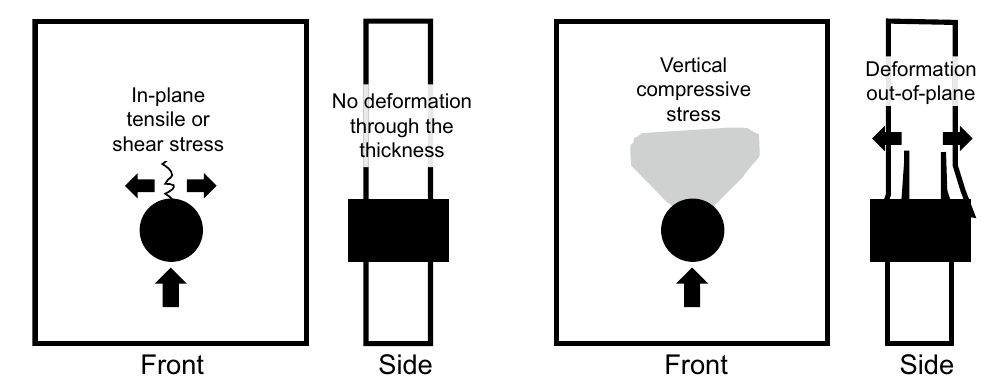
Table 2 Number of specimens where STF occurred Dowel ph position